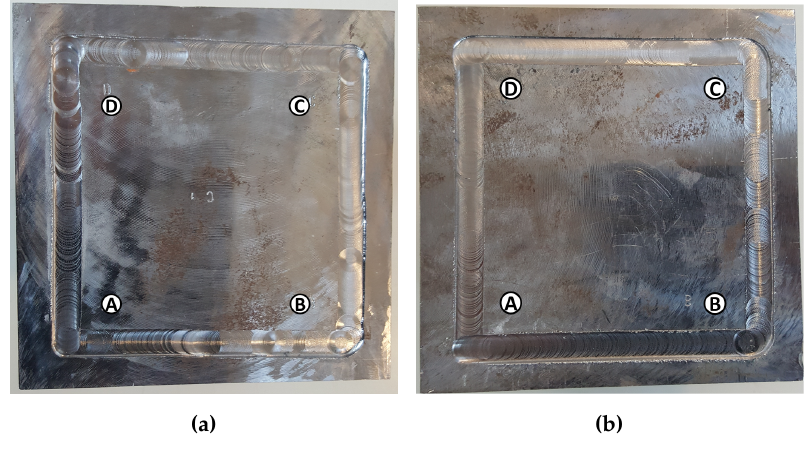
Figure 15. ( a ) Machined workpiece with automatic generated program from the planner with corners A, B, C and D; ( b ) machined workpiece without optimization following the product